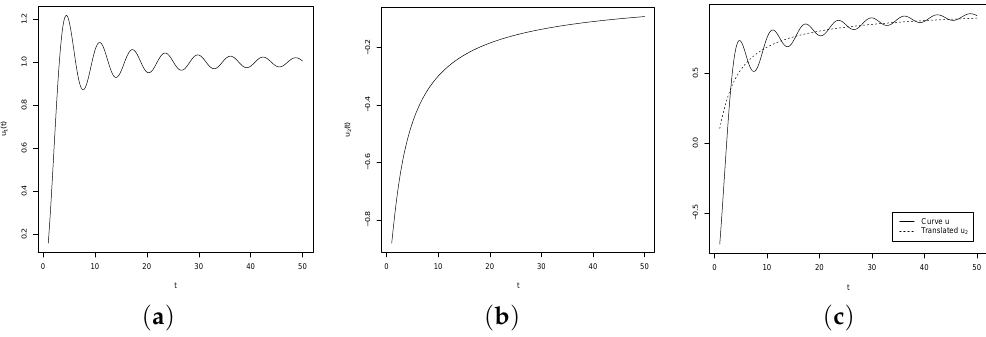
dashed line representing translated function u 2 ( t ) + ν , where ν is the average difference between u ( t ) and u 2 ( t ) .